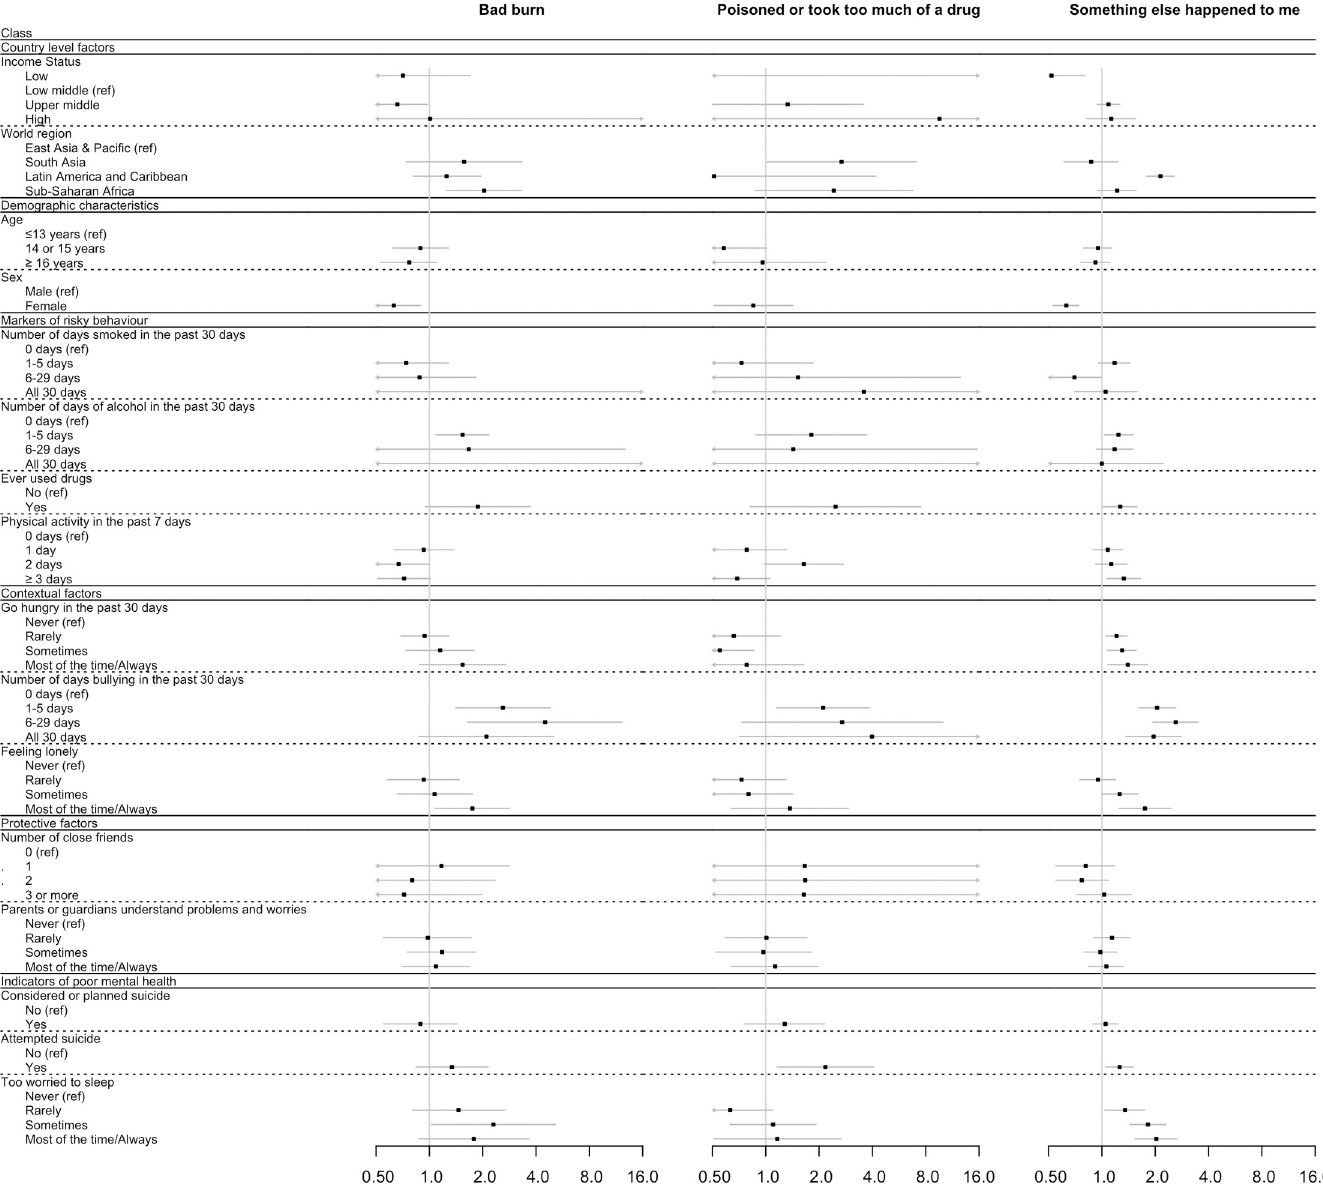
Fig 3. Forest plot showing the multivariable association (as odds ratio [OR] and 95% confidence interval [95% CI]) between serious injury type (bad burn, poisoned or took too much of a drug, and something else happened) and markers of psychosocial circumstances, adjusting for country-level factors and demographic characteristics, but not for aggressive behaviour indicators. Adjustment for non-response rate of participants was done as described in Methods. p - Values can be found in Table 5.